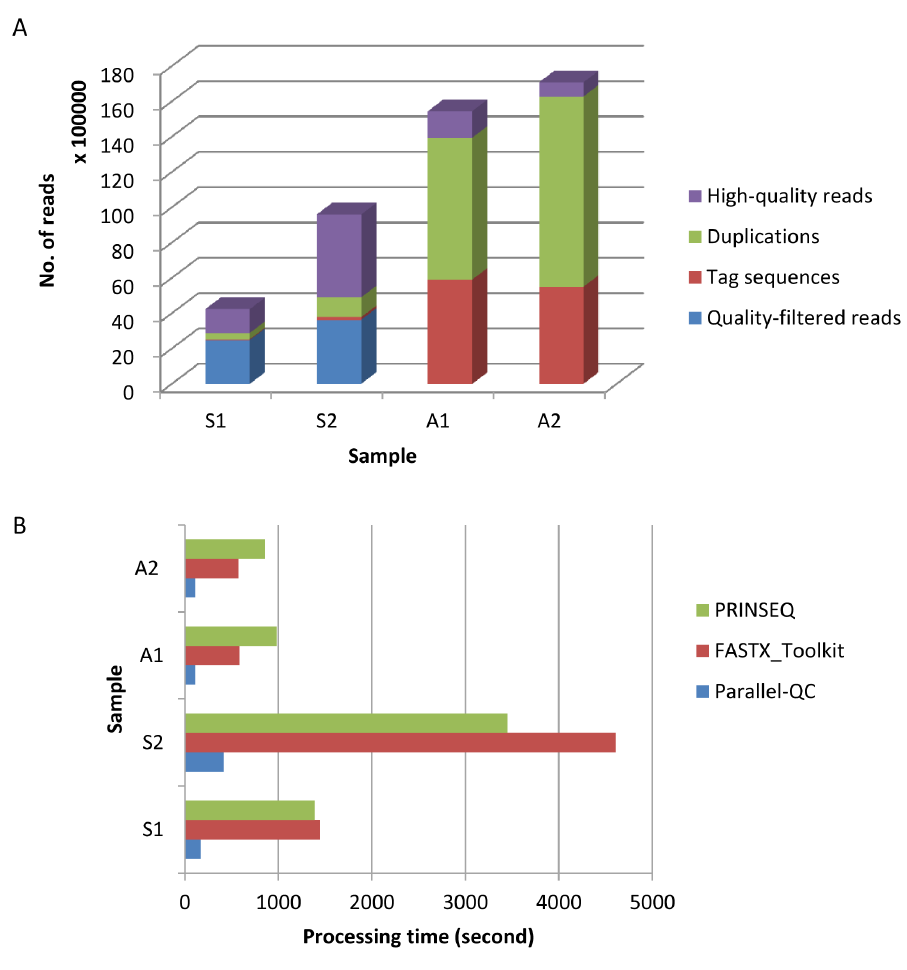
Figure 2. Evaluation of read quality on real NGS data by QC-Chain using Parallel-QC. (A) Summary of sequencing-quality evaluation. (B) Comparison of running time of Parallel-QC, FASTX_Toolkit and PRINSEQ. S1, S2: human saliva DNA samples; A1, A2: in-house sequenced algae DNA samples. All the sequences could be downloadable from http://computationalbioenergy.org/qc-chain.html.